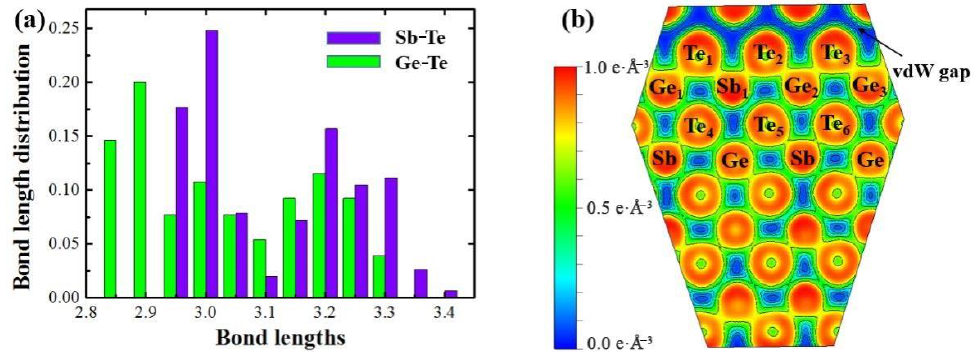
Figure 4. ( a ) Bond length distribution and ( b ) electron localization function (ELF) of the crystalline Kooi-mix model. The color scale for the ELF value is given at the left of the Figure 4b. We proposed a phase-change mechanism about the GST-SL based on the Kooi-mix model (shown in Figure 5). In this transition, the Kooi-mix model is considered as SET state. When heated by an optical or electrical pulse, the Sb atom enters the vdW gap and results in a vacancy in the Sb-rich layers. Meanwhile, the adjacent Te atom (marked by blue circle) moves toward the vacancy, resulting in the RESET state. When annealing the RESET structure of GST-SL at a proper temperature, the Sb atom in the vdW gap obtains the energy to exacerbate the thermal motion. Due to the long interaction of Sb-Te bonds (marked by a blue bond), the Sb atom is able to return to the previous position and complete the crystallization. Besides, we calculated the energy barriers (Ea) for the crystallization of GST-SL according to the free energy change during the crystallization. It was found that the Ea for this Sb atom transition was only 0.5 eV, far less than that in phase transition based on the Ge atom flipping (1.83–2.64 eV) [11,19,22]. In a summary, the Sb flipping transition is more acceptable than the Ge flipping.